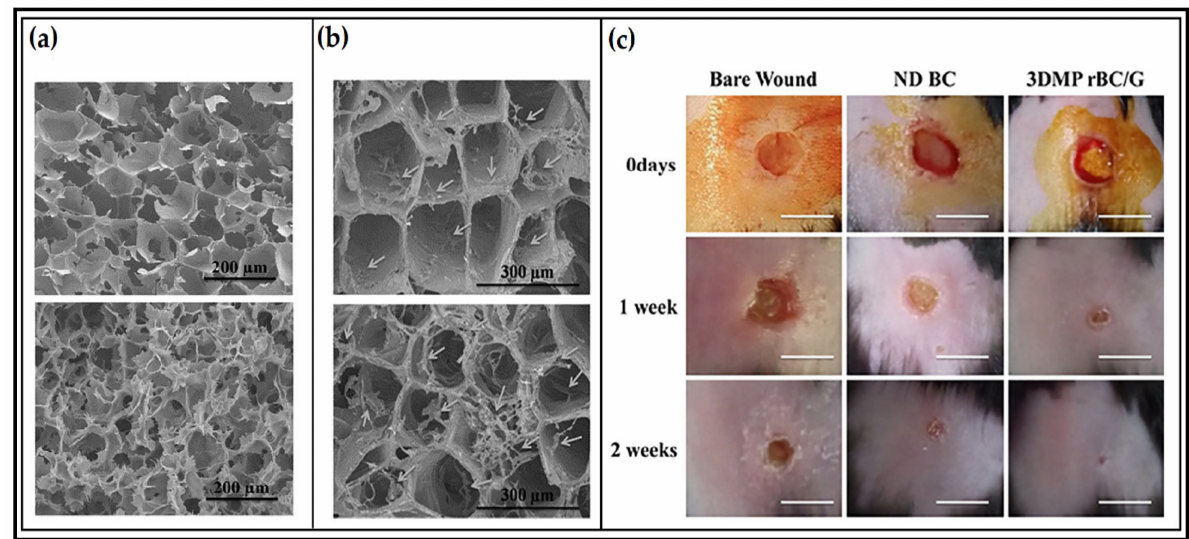
Figure 4. Illustration of the 3D micro-porous regenerated bacterial cellulose/gelatin (3DMPrBC/G) tissue scaffold: ( a ) SEM images of the scaffold, ( b ) cell adhesion and proliferation after 3 days and 7 days of incubation, ( c ) experimental in vivo skin regeneration. Adapted with permission from ref. [125]. 2018